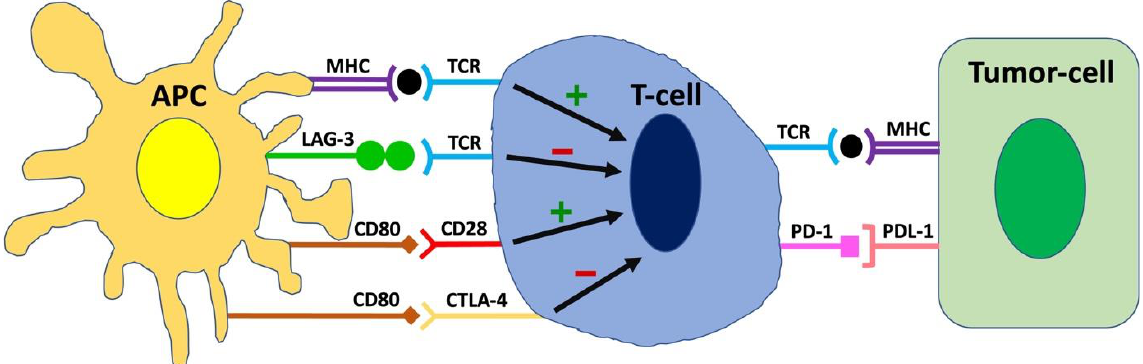
Figure 1. Interaction of immune checkpoints from antigen-presenting cells and tumor-cells with T-cells. Activation and proliferation of T-cells depend on the net results of active stimulatory and inhibitory signals. APC = antigen-presenting cell; CD = cluster of differentiation; CTLA-4 = cytotoxic T-lymphocyte antigen 4; MHC = major histocompatibility complex; PD-1 = programmed cell death 1; PD-L1 = programmed cell death ligand 1; TCR = T-cell receptor; LAG-3 = lymphocyte activation gene-3.